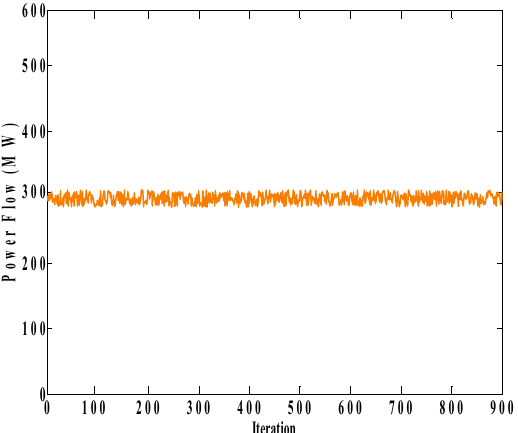
Figure 16. Power flow of Line 4 in Cases A and B when the line limit is set to 300 MW. Energies 2017 , 10 , 2045